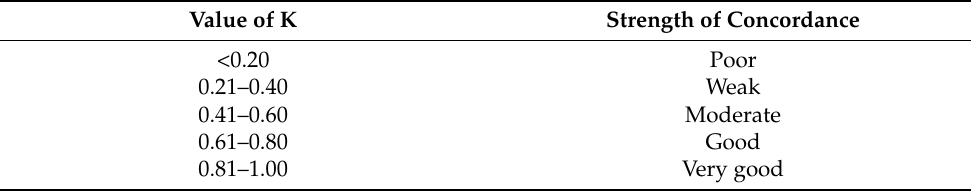
Table 2. Kappa index rating